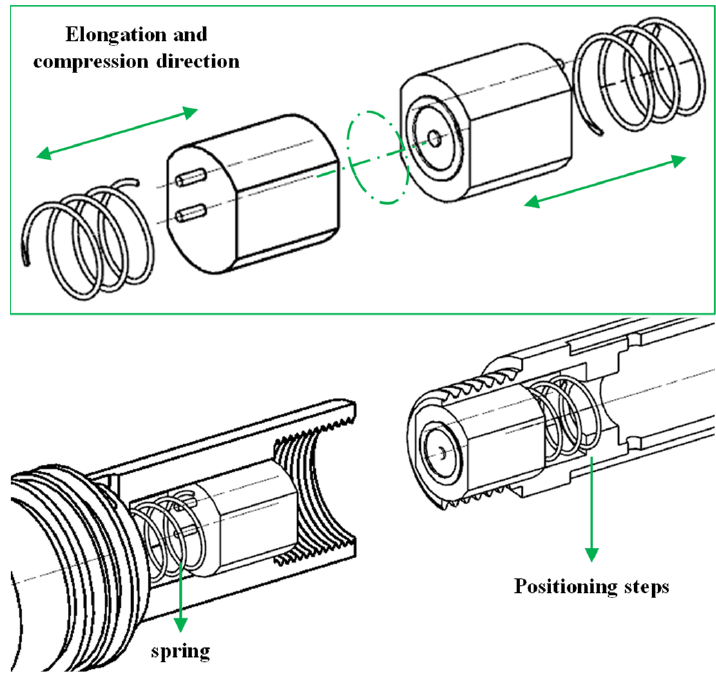
Figure 15. Conductive center pole.